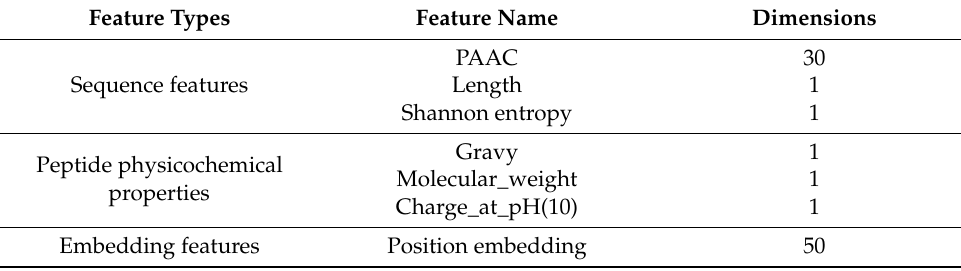
Table 2. Three kinds of hybrid features to encode peptide